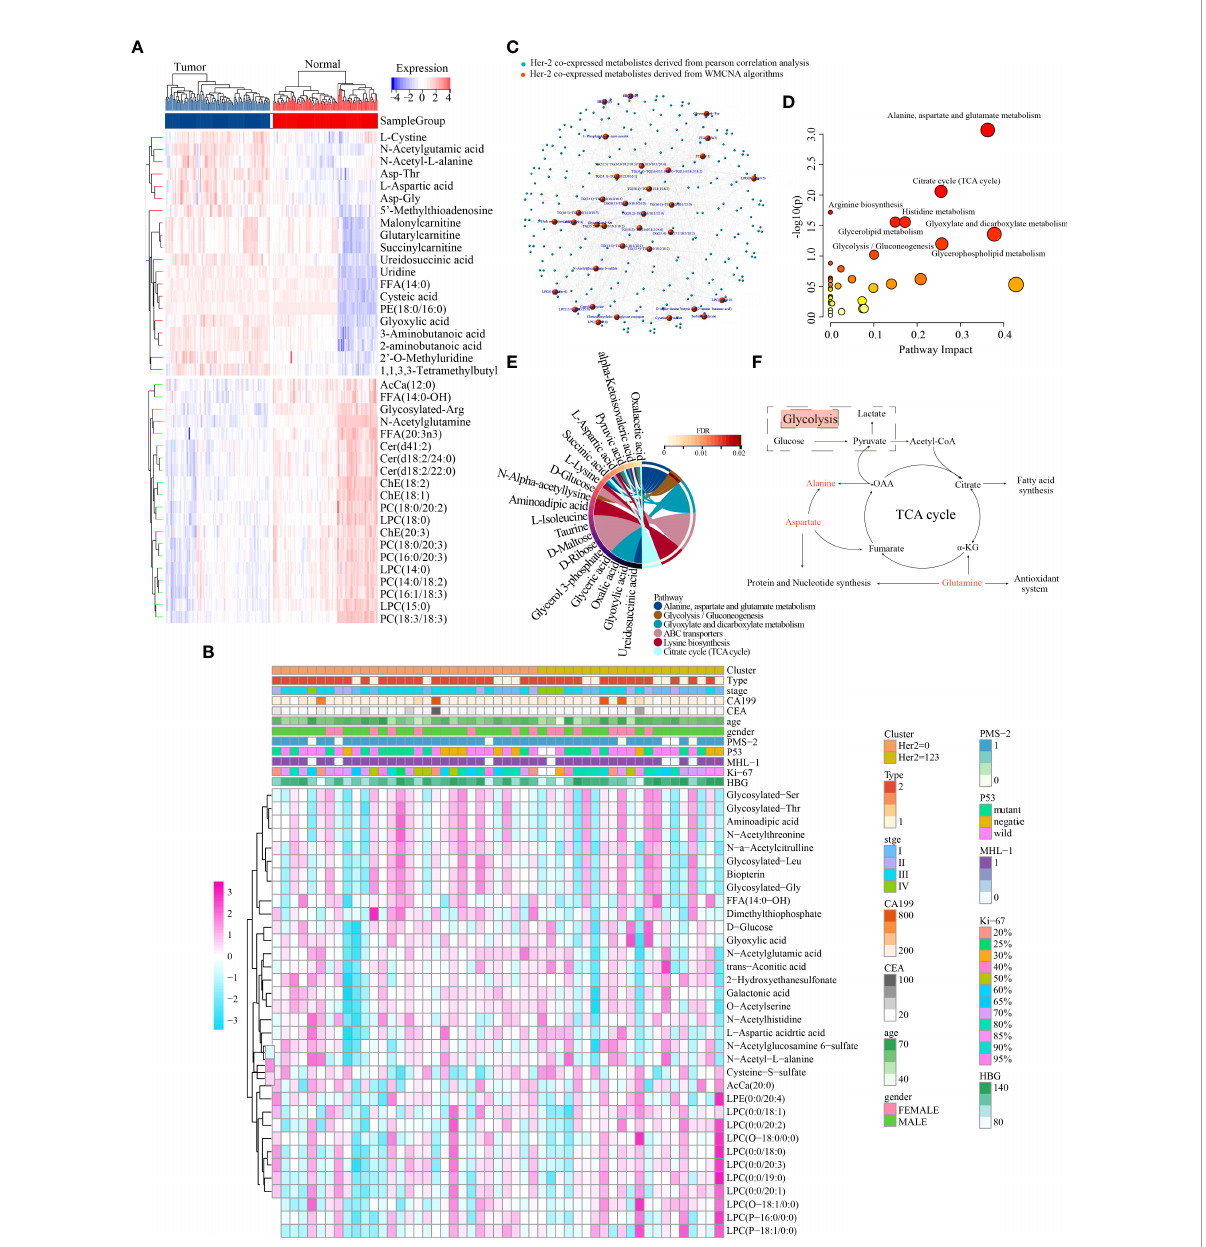
FIGURE 3 Characterisation of the metabolic landscape of GC and identi fi cation of HER2-coexpressed metabolites. (A) Differential expression heatmap of the top 40 metabolites. (B) The correlation of 34 HER2-coexpressed metabolites and clinicopathological characteristics in different clusters. (C) Development of a metabolite – metabolite interaction network. MetaboAnalyst5.0 (D) and MBROLE 2.0 (E) platforms were used to determine HER2-associated metabolic pathways. (F) Crosstalk between alanine – aspartate – glutamate and glycolysis/gluconeogenesis